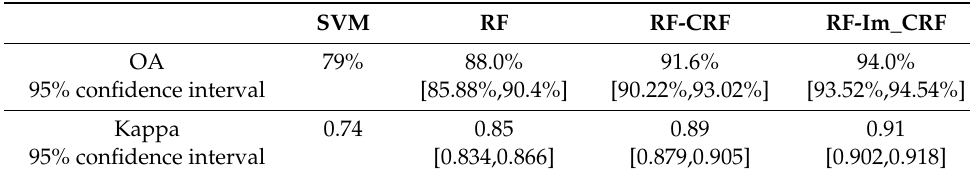
Table 2. The average of OA and